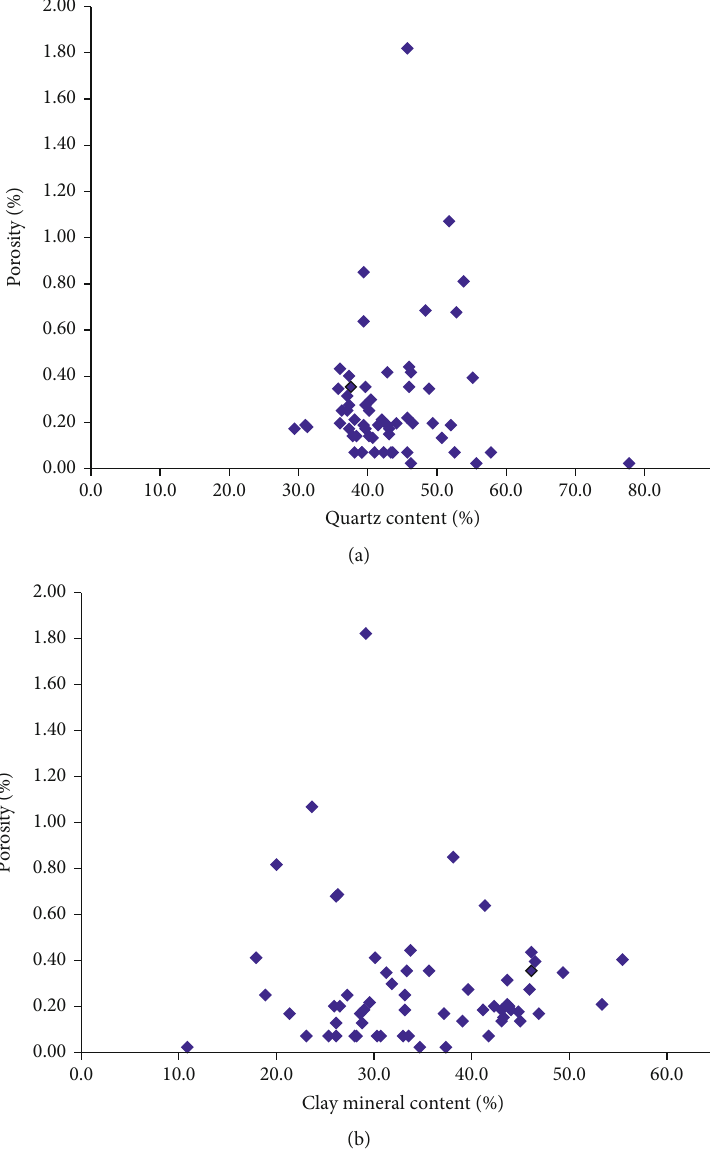
Figure 7: Relationship between porosity and (a) quartz and (b) clay mineral